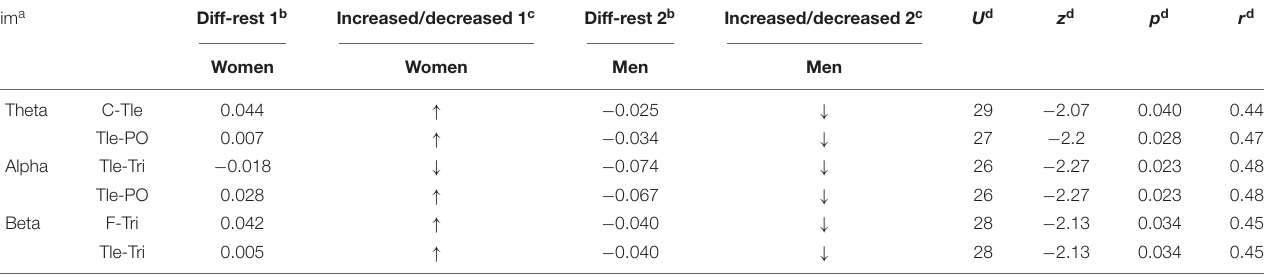
TABLE 3 | Significant between-sex/gender differences in test conditions in coherence (COH). im a Diff-rest 1 b Increased/decreased 1 c Diff-rest 2 b Increased/decreased 2 c U d z d p d r d Women Women Men Men Theta C-Tle 0.044 ↑ − 0.025 ↓ Tle-PO 0.007 ↑ − 0.034 Tle-Tri ↓ − 0.074 ↓ Tle-PO 0.028 ↑ − 0.067 ↓ Beta F-Tri 0.042 ↑ − 0.040 Tle-Tri 0.005 ↑ − 0.040 Statistically significant differences between men and women in COH. Left column, descriptive values; right column, statistical values. a im, imagined dance without music. b Diff-rest 1, difference value from pre- to post-rest-measurement in women; Diff-rest 2, difference value from pre- to post-rest-measurement in men. c Arrow up, COH increased from pre- to post-rest measurement in women (increased/decreased 1) respectively in men (increased/decreased 2); arrow down, COH decreased from pre- to post-rest measurement in women (increased/decreased 1) respectively in men (increased/decreased 2). d U-value and z-value of the Mann–Whitney U test, p-value, r-value of the effect